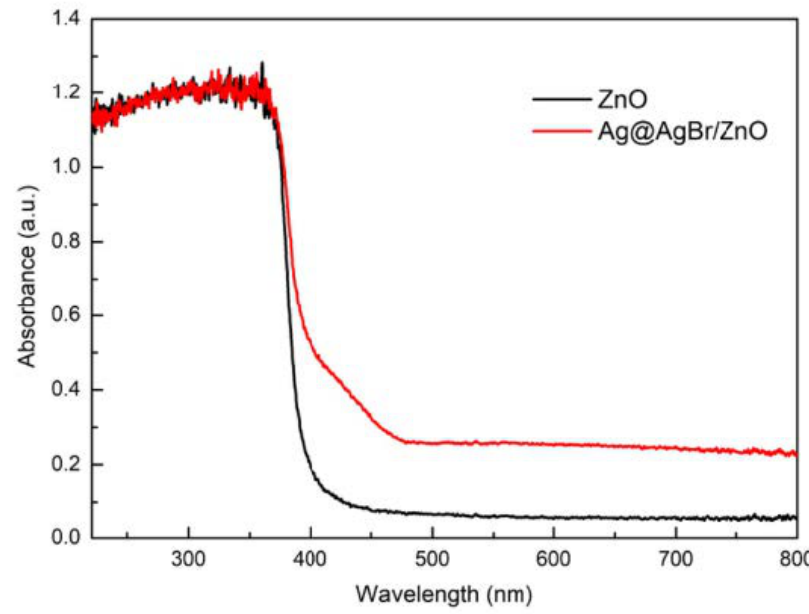
Figure 7. Comparison of UV-vis diffuse reflectance spectra before and after